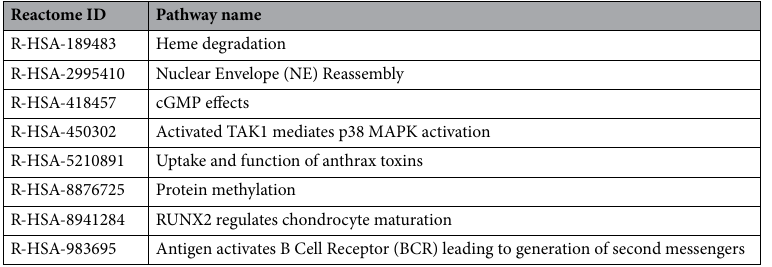
Table 2. List of enriched variant pathways shared by “multilesional” and “unilesional” patients diagnosed with Pyoderma